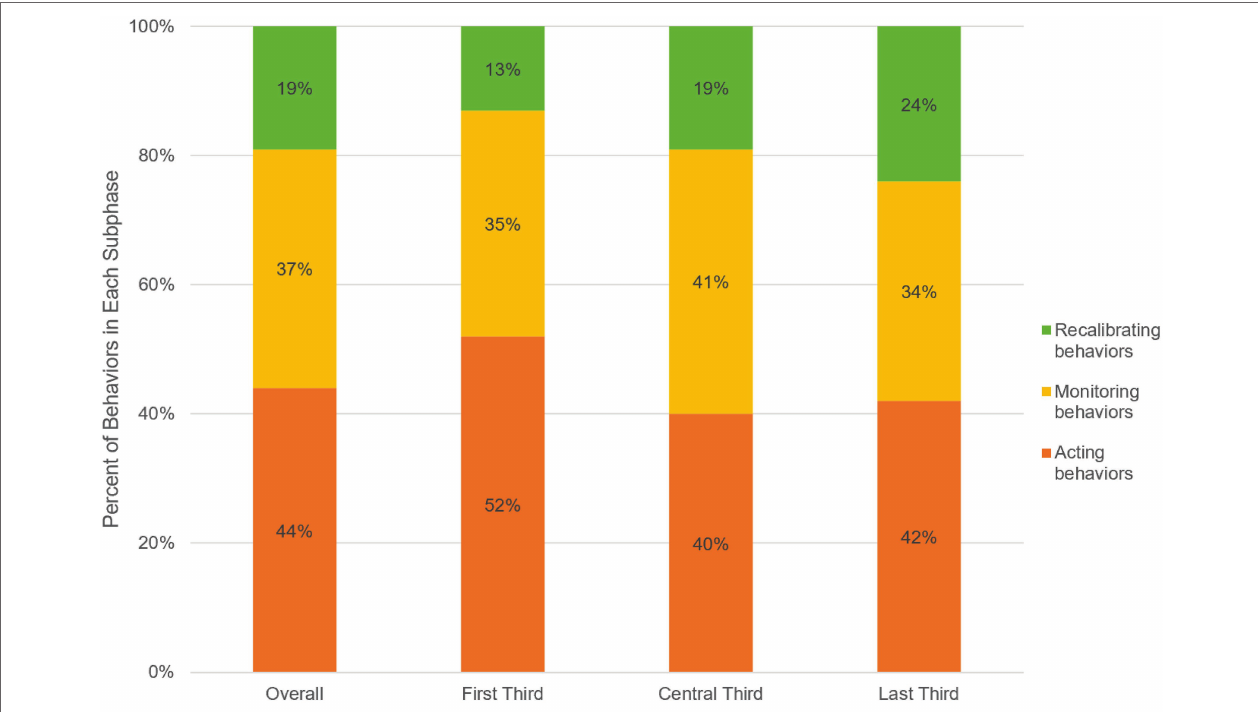
FIGURE 2 | Percent Behaviors in Each Subphase Overall and over the Action Phase of the Performance Episode. The y-axis represents the percentage of each behavior that was coded within each subphase of action performance. The x-axis includes a column for the coded behaviors that occurred both overall and within each section of the performance episode. For example, the furthest right column indicates that, of all of the behaviors coded in the last third of the performance episode, 42% were acting, 34% were monitoring, and 24% were